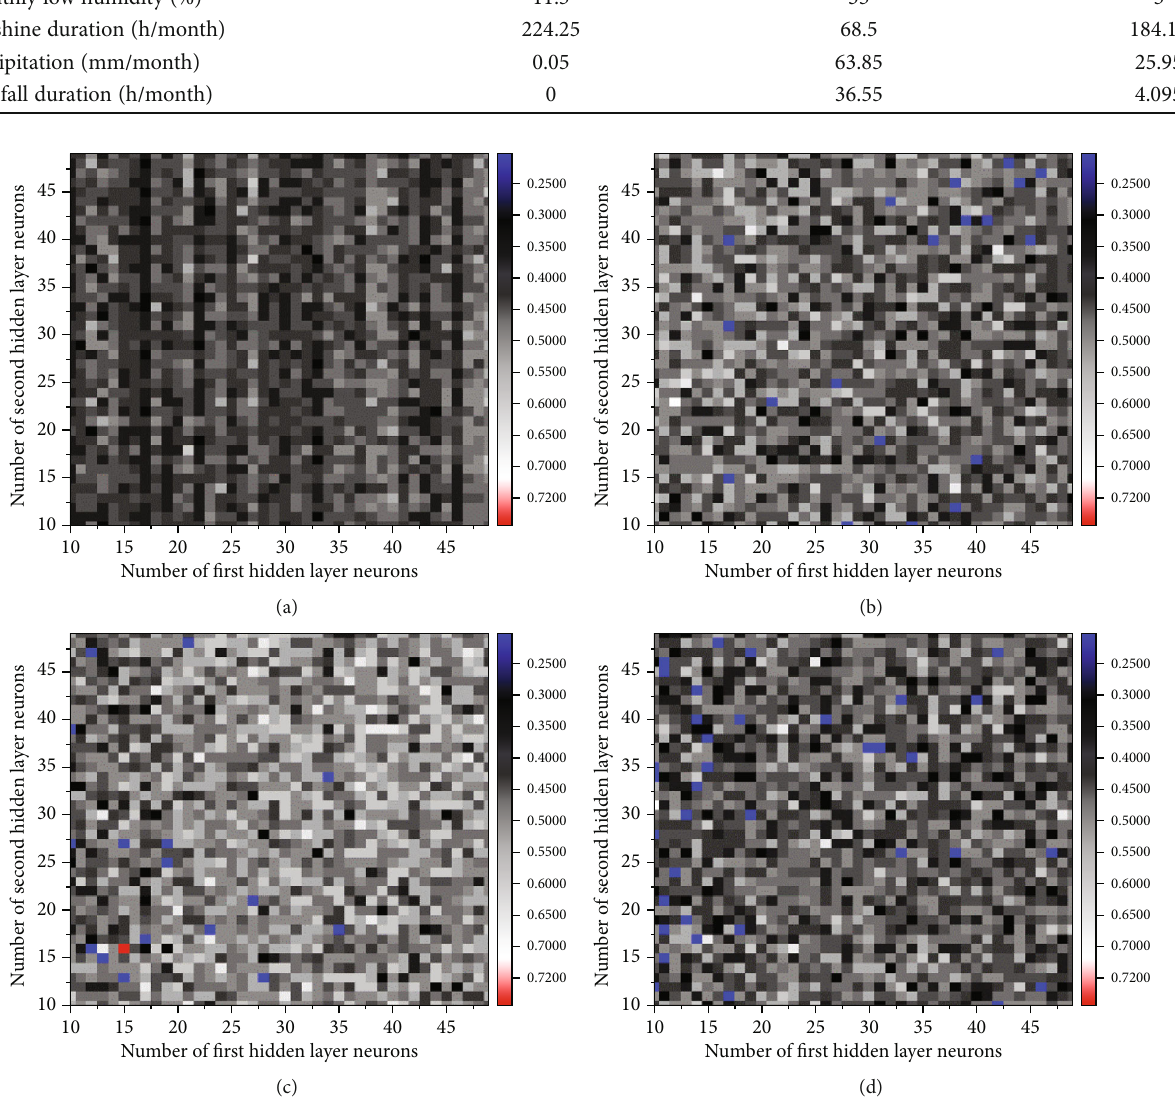
Figure 6: Performance of the explored neural network structures with the number of neurons in the two hidden layers varying between 10 and